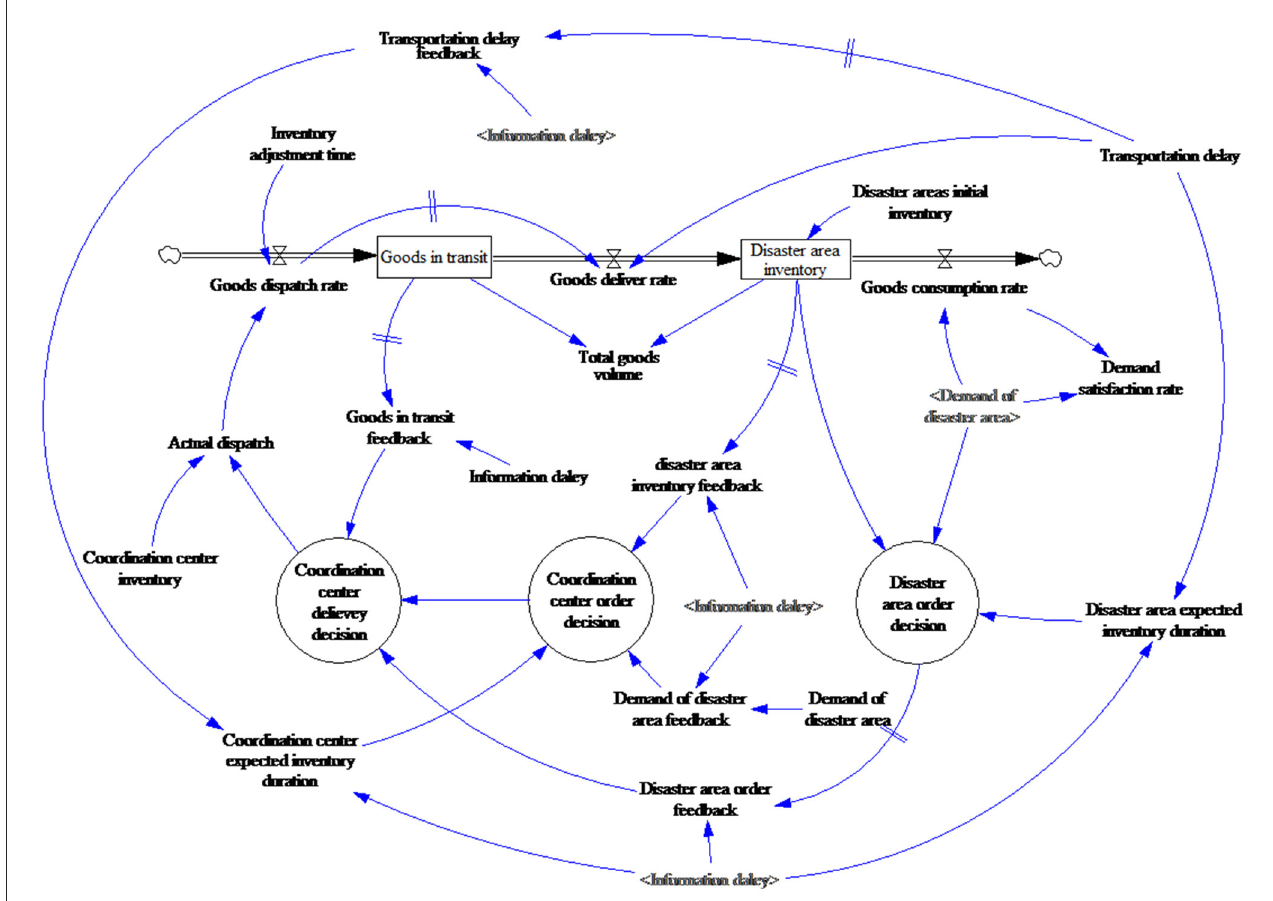
FIGURE7 Relief goods supply system stock and flow diagram.